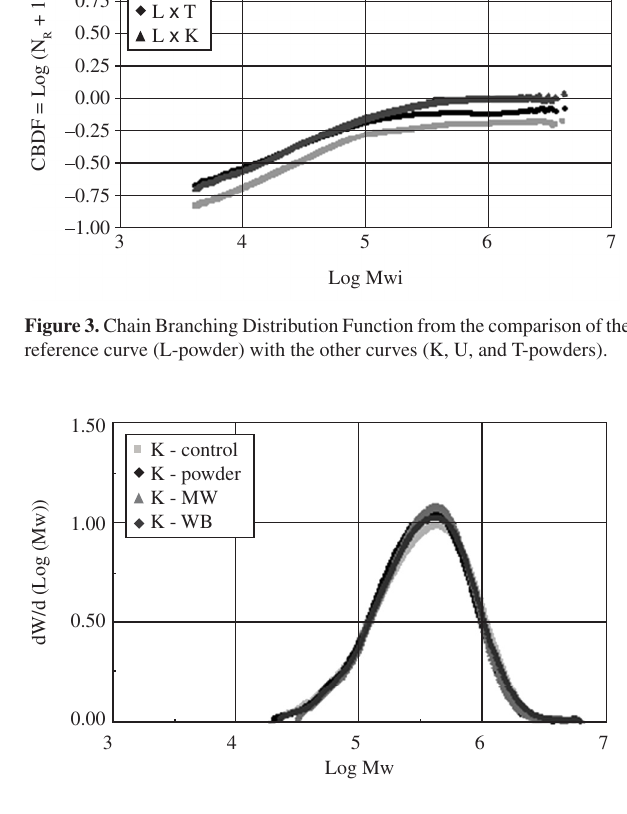
Figure 4. Molecular weight distribution curves for K powder, K control, K after post-polymerization treatments (MW and WB).